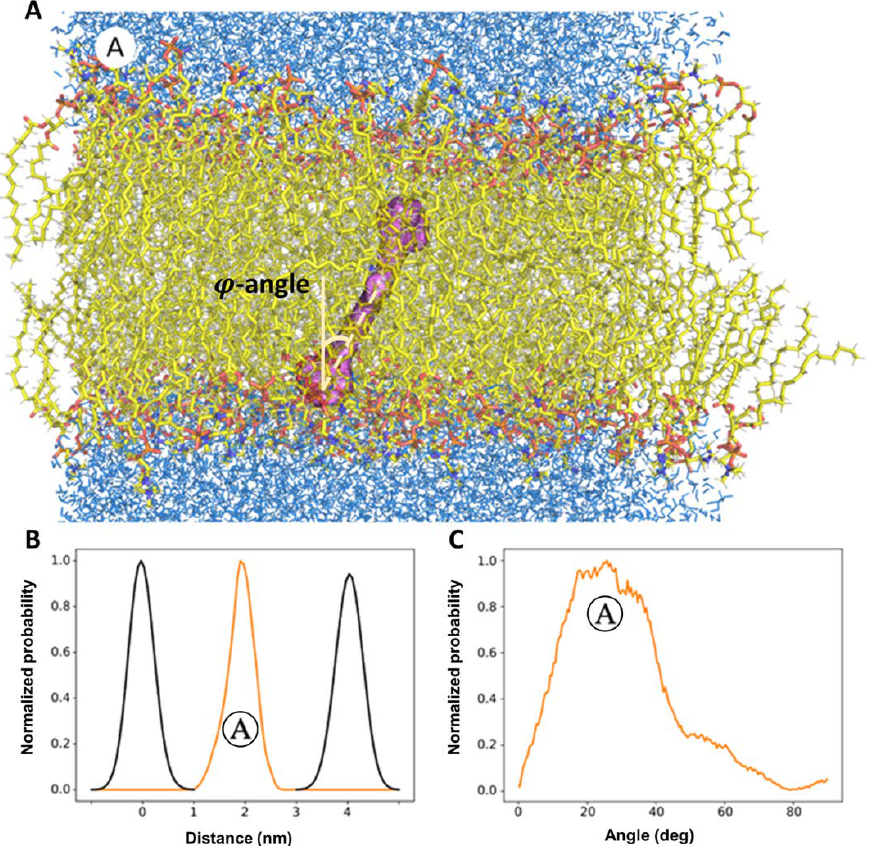
Figure 5. Results of molecular dynamics simulations of equilibrium localization of echinenone (ECN) molecule in the bilipid layer. Data was visualized based on the analysis of the trajectory of the center-mass of ECN molecule. ( A )—possible localization of ECN in the membrane where it occupies only one position (designed as state Ⓐ ) during the whole exposition of the stimulation. ( B )—the probability density function (orange-colored curve) for the localization of the ECN center of mass along the normal to the membrane plane, black-colored curves represent the boarders of the bilipid membrane. ( C )—the probability density function for the angle between the long axis of the molecule and the normal to the membrane plane.